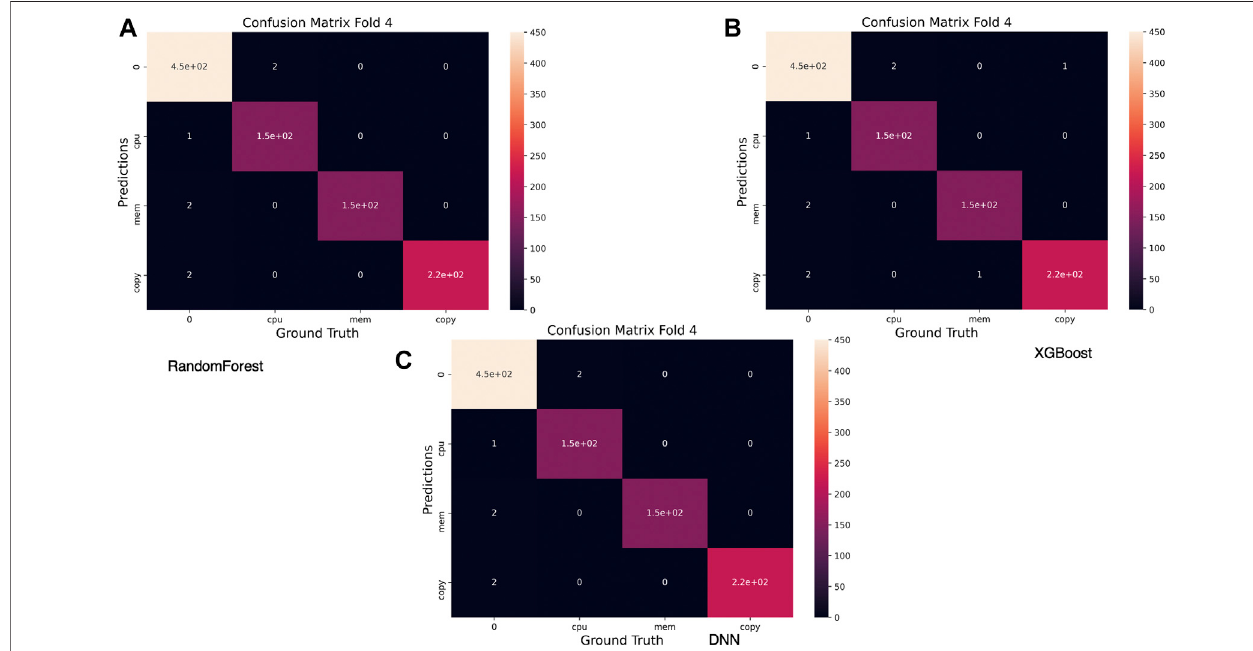
FIGURE 10 | Confusion matrix for best performing validation fold.